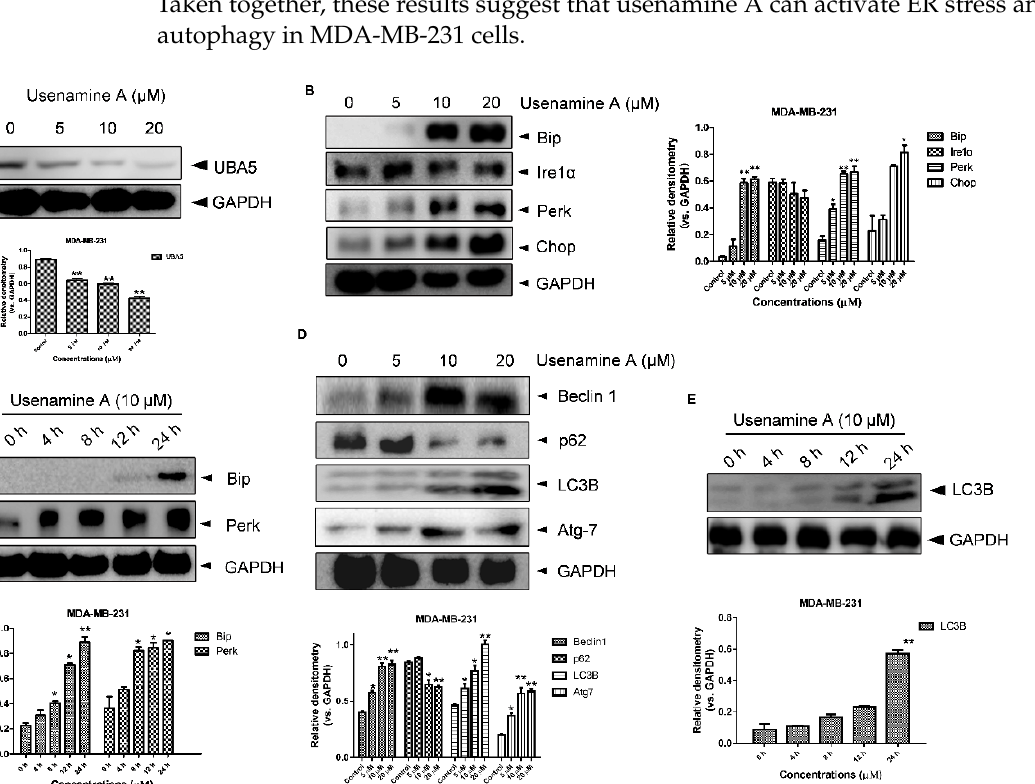
9 of 16 Figure 4. Apoptosis and cell cycle distribution analyses of MDA-MB-231 cells treated with usena- mine A. ( A , B ) Apoptosis as determined by flow cytometry analysis following treatment with usena- mine A (0, 5, 10, 20 μM) for 48 h. The apoptosis rate is the sum of the early and late apoptosis rates.